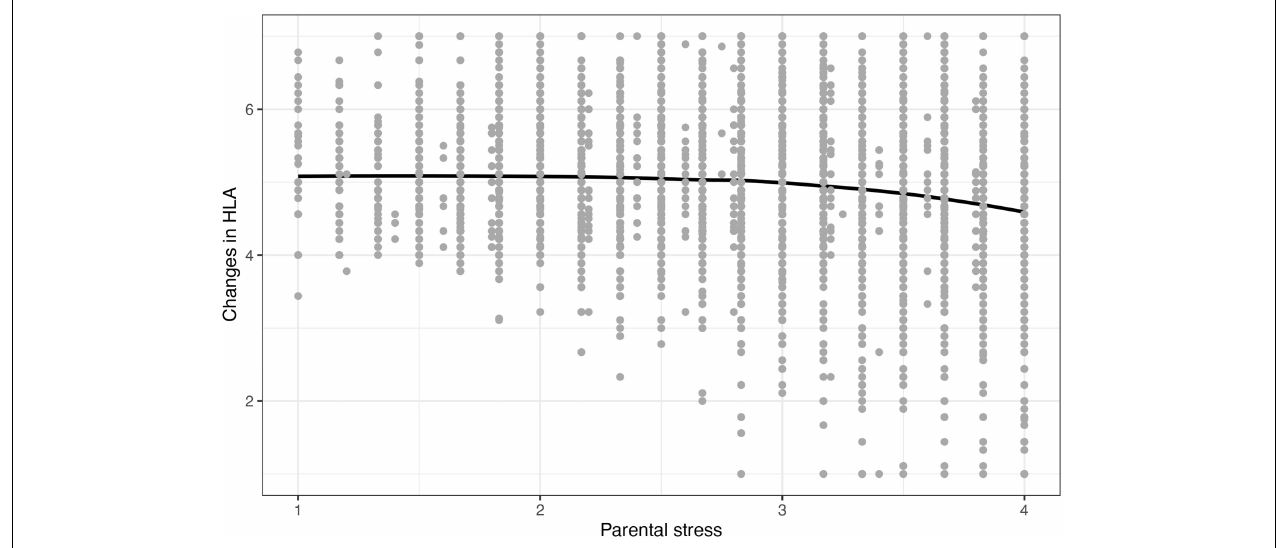
FIGURE 1 | LOESS curve showing the relation between perceived parental stress and changes in HLA.